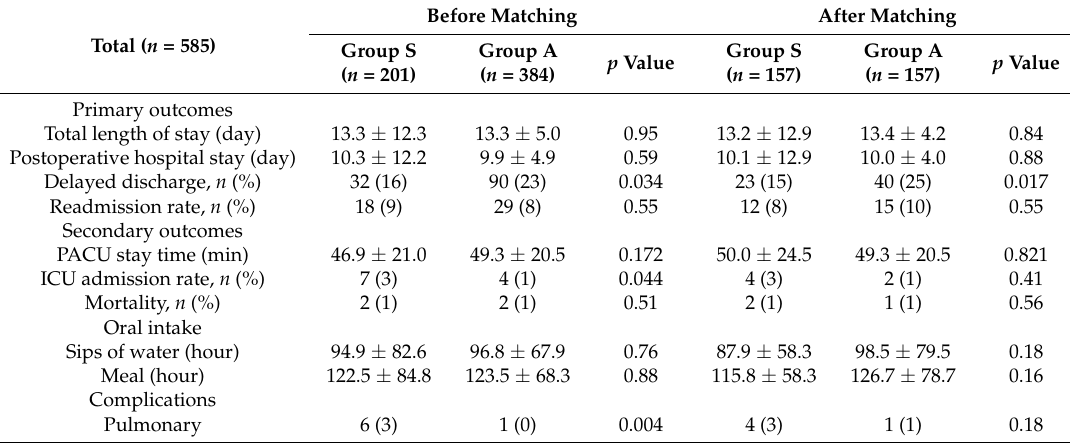
Table 2. Postoperative